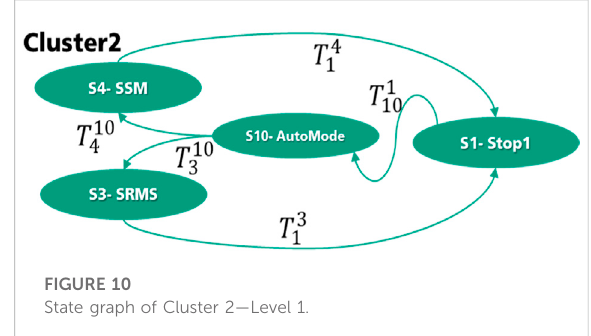
FIGURE 10 State graph of Cluster 2 — Level